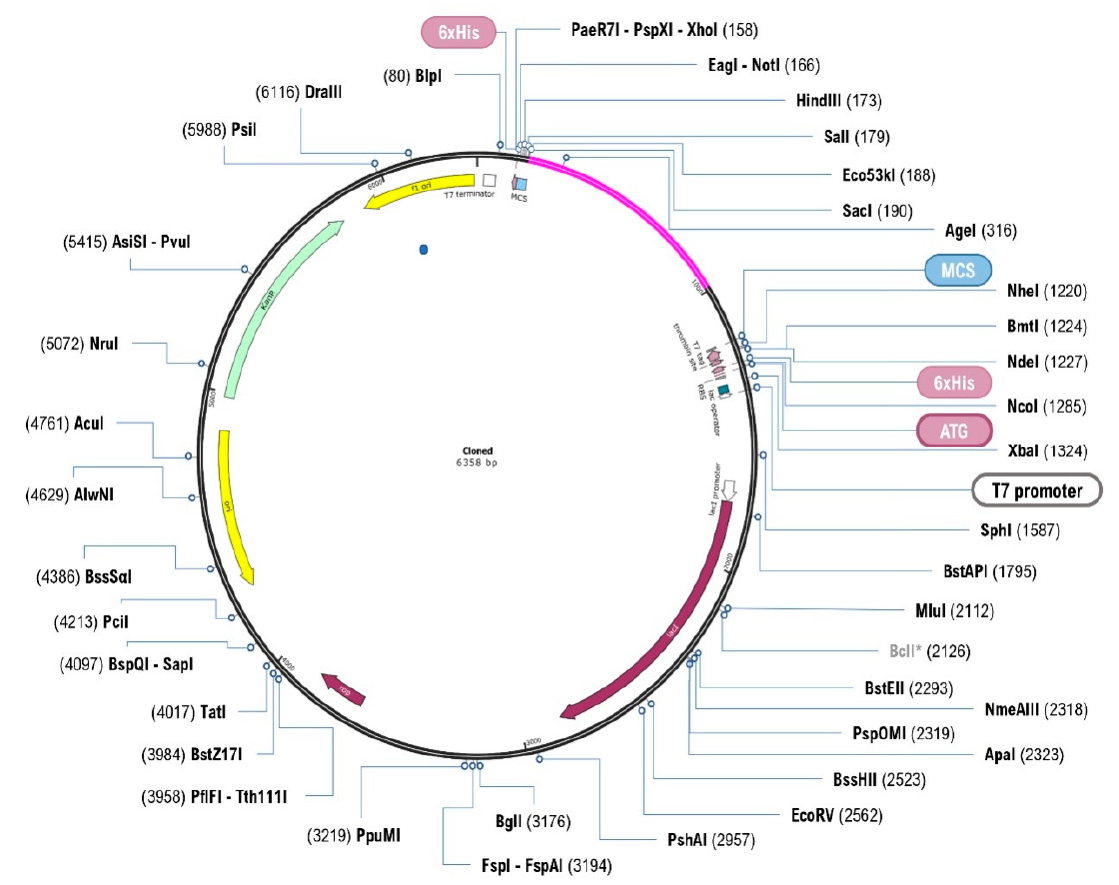
Figure 10. Restriction cloning of final multi-epitope vaccine 651 by using pET28a (+) expression vector in the in silico space. Black circle indicates the vector, and the magenta part is the place where the vaccine is inserted.